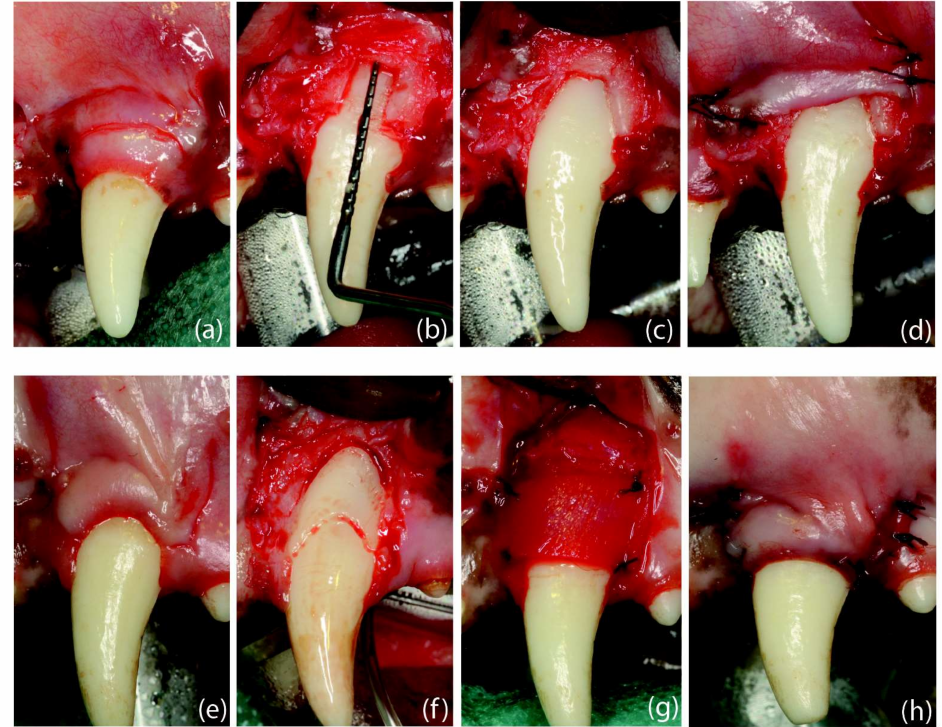
Figure 5. Surgical interventions: ( a ) dehiscence-type defect creation; ( b ) root coverage procedure. Defect creation: ( a ) Scalloped incision, preserving 3 mm of keratinized tissue, followed by two horizontal incisions (2 mm) and two vertical releasing incisions extending 5 mm in the alveolar mucosa. ( b ) Removal of the buccal bone until reaching a vertical distance from the cemento-enamel junction to the mid-buccal bone of 5 mm. ( c ) Bone removal until showing the mesio-distal dimension of the root. ( d ) Flap sutured in an apical position. Root Coverage Surgery: ( e ) Design of the coronally advanced flap (4 weeks after defect creation) by performing two horizontal beveled incisions (at the level of the buccal cemento-enamel junction) at the mesial and distal aspects of the tooth with the recession defect followed by two vertical, slightly divergent releasing incisions. ( f ) Coronal notch performed at the level of the gingival margin and apical notch at the level of the bone crest, after flap-raising with a split–full–split approach; de-epithelialized papillae. ( g ) Suture of the collagen matrix with simple stitches. ( h ) Flap sutured in a coronal